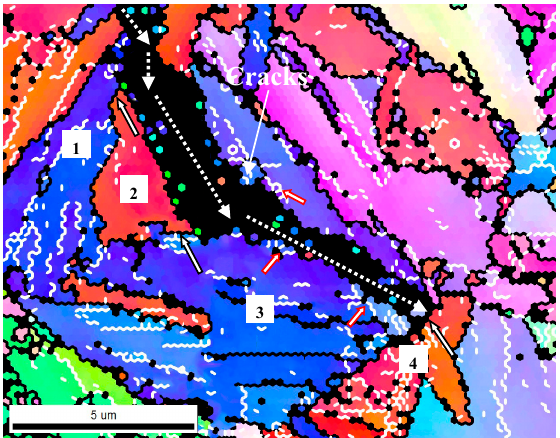
Figure 1. The optimum imitated Equations (5)–(7) for the samples tempered at 650, 700 and 720 ◦ C, respectively, as follows: